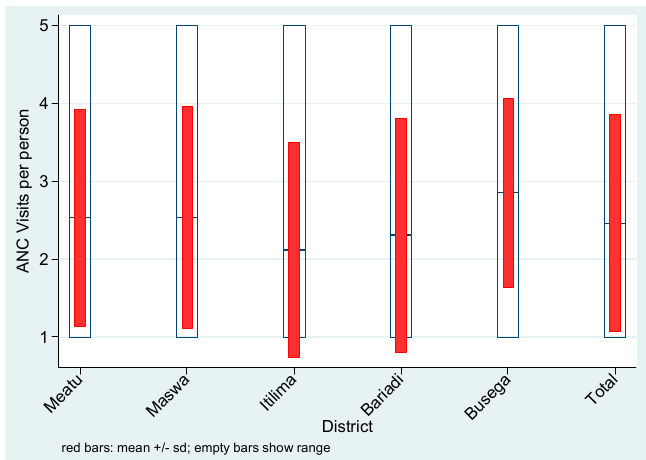
red bars: mean +/- sd; empty bars show range